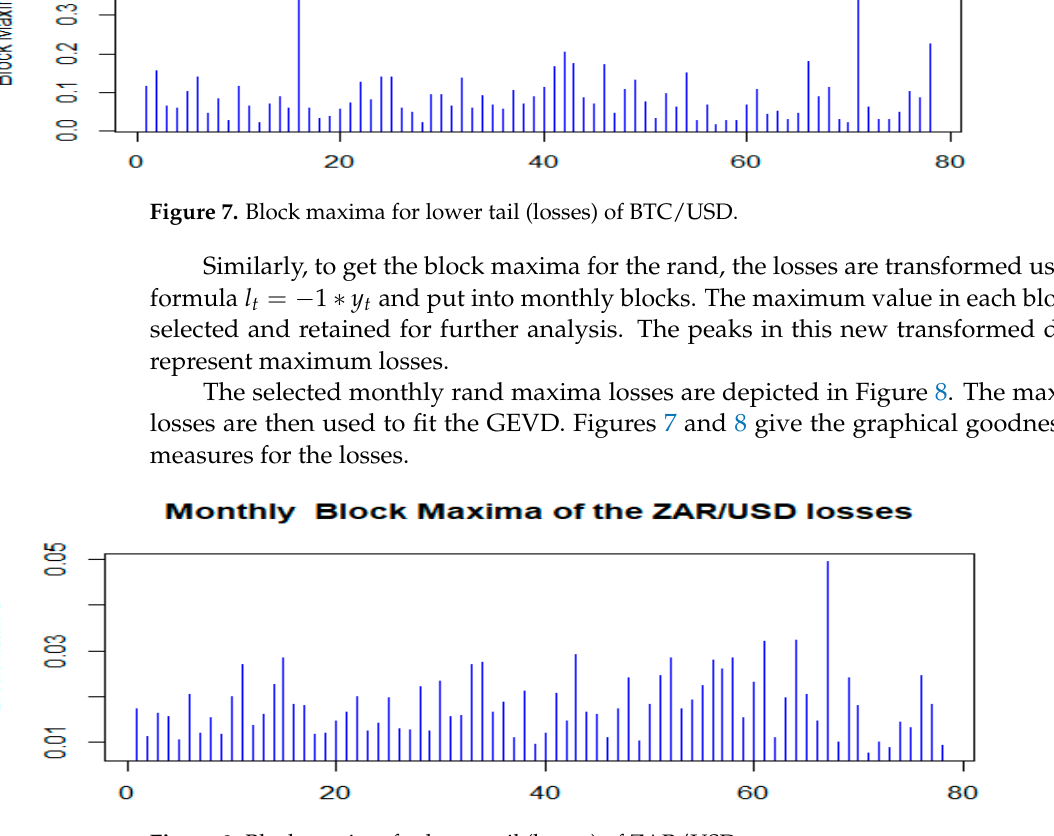
Figure 8. Block maxima for lower tail (losses) of ZAR/USD. 4.3. Model Diagnostics for the Maxima of the BTC/USD (Lower Tail, Loses or Minima Returns) In Figure 9, the probability and quantile plots for the BitCoin returns do not deviate much from the straight line, suggesting that the GEVD model is ideal for BitCoin losses. The return level plots indicate that there are no significant deviations from the given confidence level band. The density plot is a good estimate of the histogram of the BitCoin losses data.